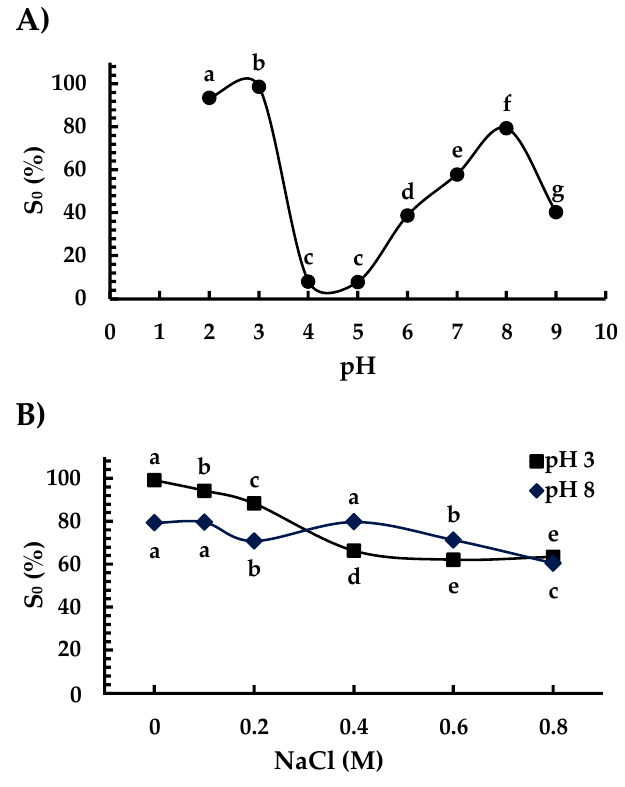
Figure 7. Solubility of Ah11Sn at different pH values ( A ) and concentrations of NaCl ( B ). The different letters at different pH values ( A ) or pH 3 or 8 ( B ) indicate significant differences at p < 0.05.